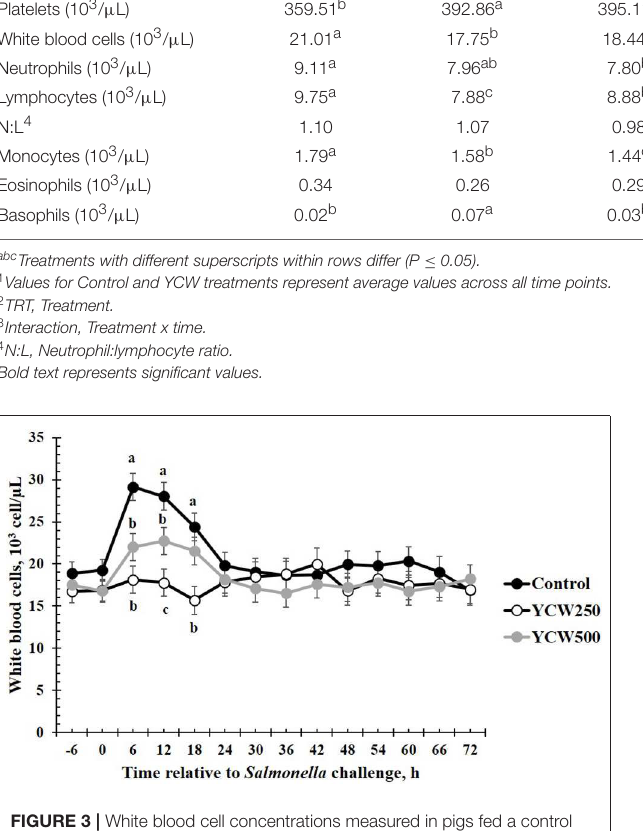
FIGURE 4 | Neutrophil concentrations measured in pigs fed a control (Control) diet or supplemented with a yeast cell wall at 250 mg/kg (YCW250) or 500 mg/kg (YCW500), following administration of an oral Salmonella Typhimurium challenge on d 19. ab Treatments differ P ≤